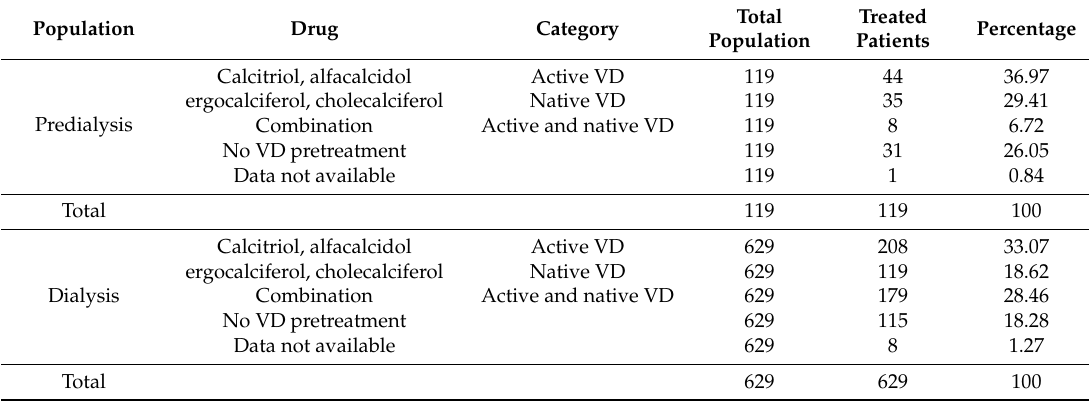
Table 6. Vitamin D pretreatment for the predialysis and dialysis population.